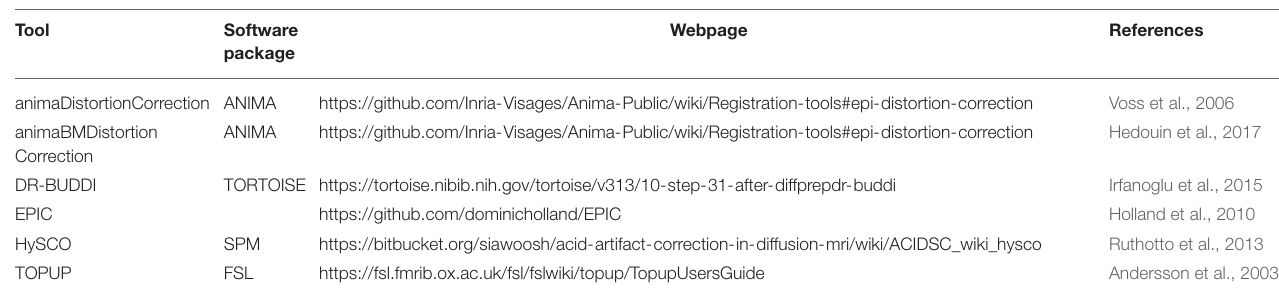
TABLE 1 | Phase encoding based susceptibility distortion correction tools evaluated in this paper. Tool Software